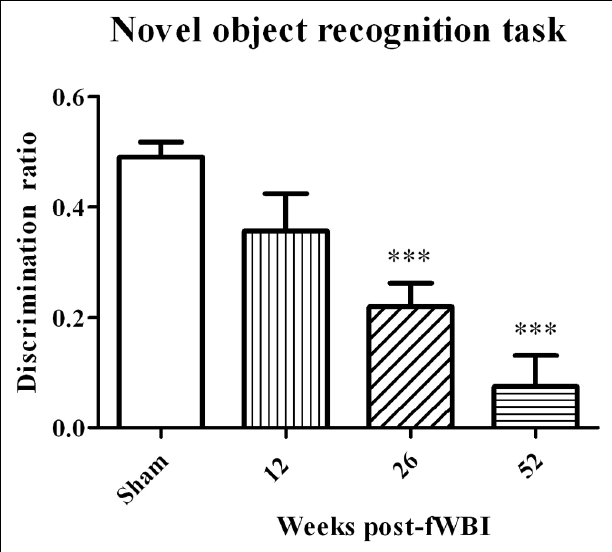
FIGURE 3 | Development of radiation-induced cognitive impairment as a function of time after young adult male Fischer 344 X Brown Norway rats were irradiated with a total 40 Gy dose of fWBI delivered as 5 Gy fractions, twice/week for 4 weeks. Cognition was assessed using the novel object recognition (NOR) task.The sham-irradiated group value is the average of the NOR scores from unirradiated rats at all of the time points. In this rat model, cognitive impairment is both progressive and not significantly different from sham-irradiated rats until ∼ 6 months after fWBI, similar to what is observed in the clinic. *** P < 0.001.